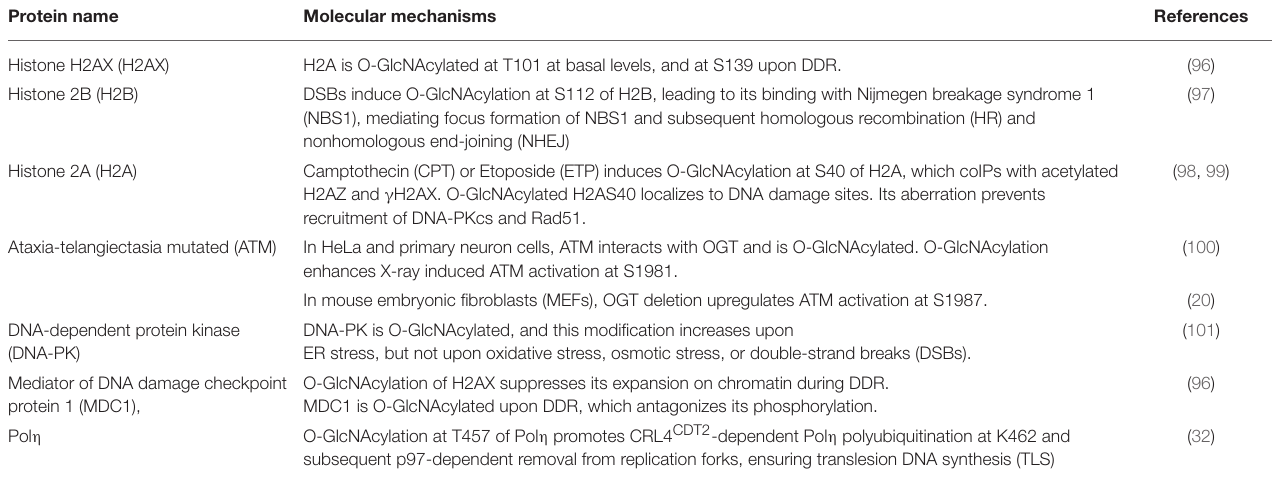
TABLE 3 | O-GlcNAcylated proteins during the DNA damage